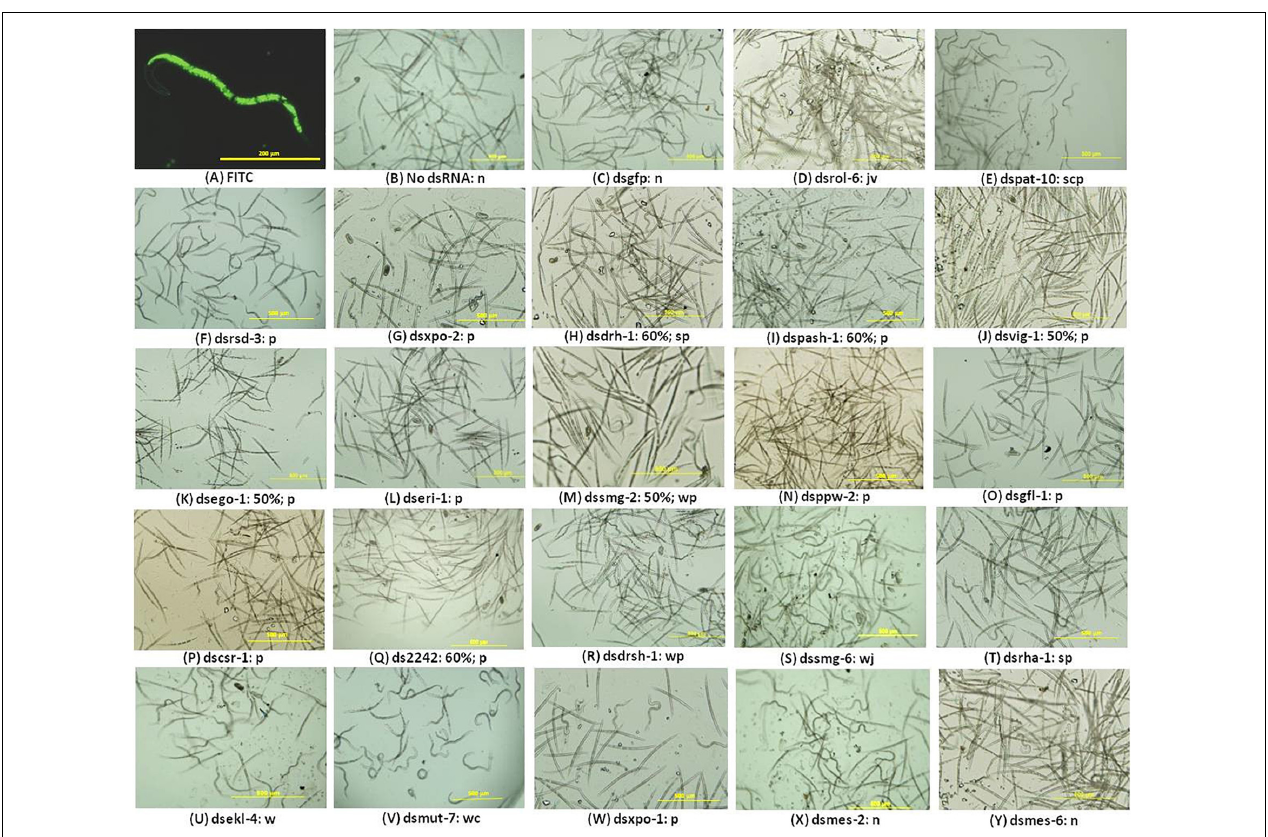
FIGURE 1 | RNAi phenotypes of M. incognita J2s after soaking in buffered solution containing dsRNA (1 mg mL − 1 ) of 22 nematode genes. (A–E) Control RNAi treatments with J2s soaked with 1 mg mL − 1 FITC (A) or soaked without dsRNA (B) or with dsRNAs of the gfp gene (C) , or of the nematode genes rol-6 (D) , and pat-10 (E) . (F–Y) J2s treated with dsRNA of 20 genes of the RNAi pathway. Images are denoted by the dsRNA (ds) of the target gene, percentage of nematodes affected after RNAi, and the RNAi phenotypes denoted as n = normal, s = straight, p = paralyzed, c = curvy, w = wavy, j = captured during a jerky action, v = captured during vigorous movement. No percentage is indicated where over 60% of the nematodes exhibited one or more of the phenotypes indicated. Scale bar: 200 µ m (FITC) and 500 µ m. Phenotypic observations and estimates of percentages of nematodes exhibiting any phenotype were based on three biological